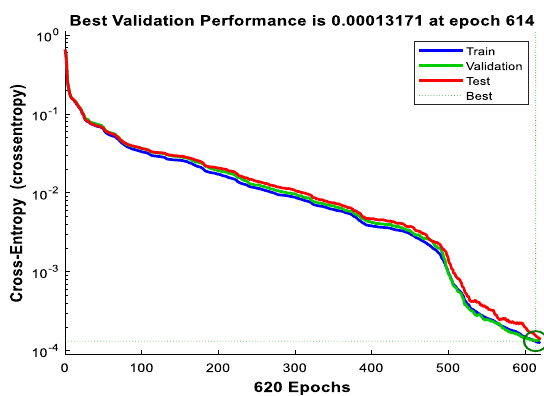
Fig. 8 Cross-entropy reduction after each